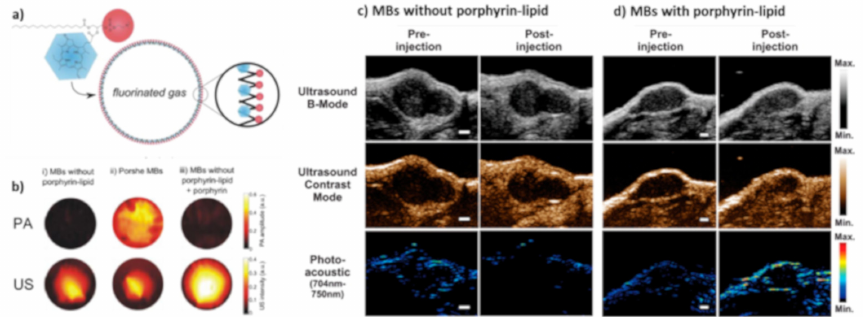
Figure 6. Left: ( a ) Conceptual representation of self-assembled chlorin-phospholipid microbubbles with heavy gaseous cores; ( b ) the phantom PA signals of the microbubbles with and without chlorin, along with US images; Right: in vivo tumor accumulation US / PA imaging of ( c ) MBs without chlorin, and ( d ) MBs with porphyrin before and after the infusion. Adapted with permission from References [73,77]. Copyright: (2012; 2014) American Chemical